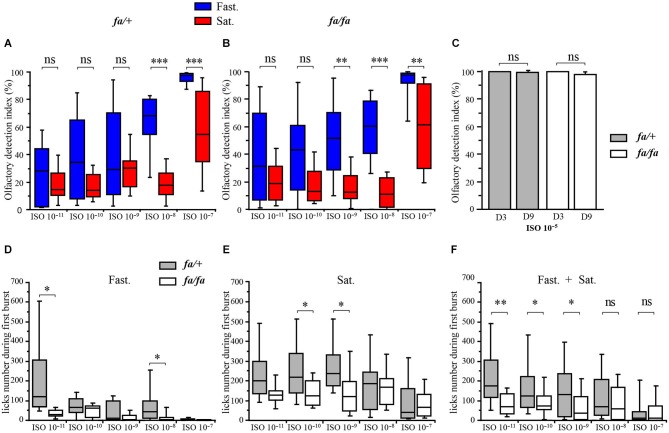
 Modulation of olfactory abilities of fa/+ and fa/fa Zucker rats by feeding state. Each animal was successively tested in fasted (Fast., in blue) and satiated (Sat., in red) states. (A, B, D, E, F) Values are shown as medians ± interquartile range, n = 6 per group (satiated and fasted rats); per rat genotype (fa/+ and fa/fa rats); per ISO dilution. (A, B) Box graphs showing the olfactory detection index corresponding to the percentage of licks at the pure water tube normalized to the total number of licks in the experimental cage when rats were given the choice between pure water and odorized water at ISO 10−11, ISO 10−10, ISO 10−9, ISO 10−8, ISO 10−7. The mean olfactory detection indexes were significantly higher for fasted fa/+ rats compared to satiated fa/+ rats for ISO 10−8 and ISO 10−7. The mean olfactory detection indexes were significantly higher for fasted fa/fa rats compared to satiated fa/fa rats for ISO 10−9, ISO 10−8 and ISO 10−7. (C) Aversion test and aversion re-test. Bar graphs showing the olfactory detection indexes of fa/+ (gray bars) and fa/fa (white bars) rats for the aversion test (Avers. Test, D3) and re-test (Avers. re-test D9). The olfactory detection indexes for fa/+ and fa/fa rats were not significantly different and close to 100% before (at day 3) and after (at day 9) the olfactory detection test. (D–F) Box graphs showing the number of licks during the first ISO consumption in the experimental device. (D) In fasted state (Fast.), the mean number of licks during the first ISO consumption was significantly lower for fa/fa rats compared to fa/+ rats for ISO 10−11 and ISO 10−8. (E) In satiated state (Sat.), the mean number of licks during the first ISO consumption was significantly lower in fa/fa rats compared to fa/+rats for ISO 10−11 and ISO 10−9. (F) The mean number of licks during the first ISO consumption was significantly lower for fa/fa rats compared to fa/+ rats for ISO 10−11, ISO 10−10 and ISO 10−9 regardless to feeding state.